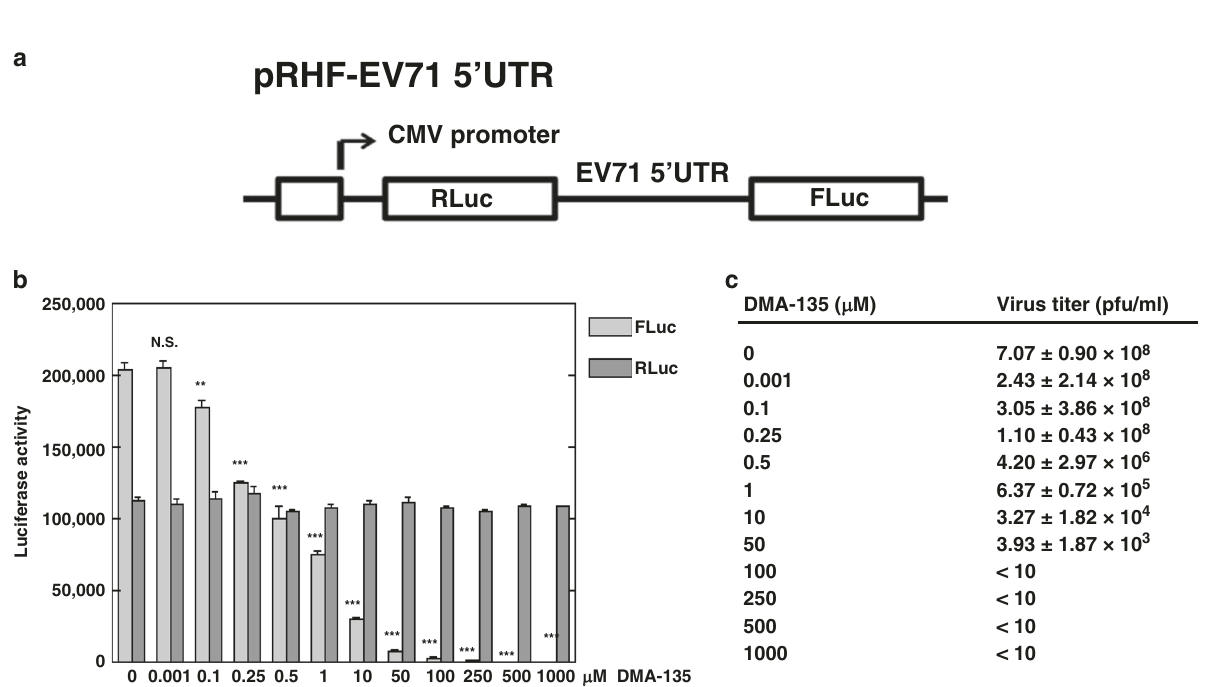
Fig. 3 DMA-135 inhibits EV71 IRES-dependent translation and replication. a The diagram depicts the bicistronic reporter plasmid used to synthesize RNA for transfections and dual-luciferase assays. b Effect of DMA-135 on EV71 IRES activity. SF268 cells were transfected with RLuc-EV71-5 ′ UTR-FLuc RNA and cultured with various concentrations of DMA-135. Luciferase activity was measured 2 days later. Mean values± standard deviations from three independent experiments ( N = 3) are shown in the bar graphs. P values were determined by unpaired two-tailed Student ’ s t test. *** P < 0.001; ** P < 0.01; N.S., not signi fi cant. 0.001 µ M : P = 0.867669; 0.1 µ M : P = 0.006658; 0.25 µ M : P = 0.000011; 0.5 µ M : P = 0.000305; 1 µ M : P = 0.000031; 10 µ M : P < 0.00001; 50 µ M : P < 0.00001; 100 µ M : P < 0.00001; 250 µ M : P < 0.00001; 500 µ M : P < 0.00001; 1000 µ M : P < 0.00001. c Effect of DMA-135 on